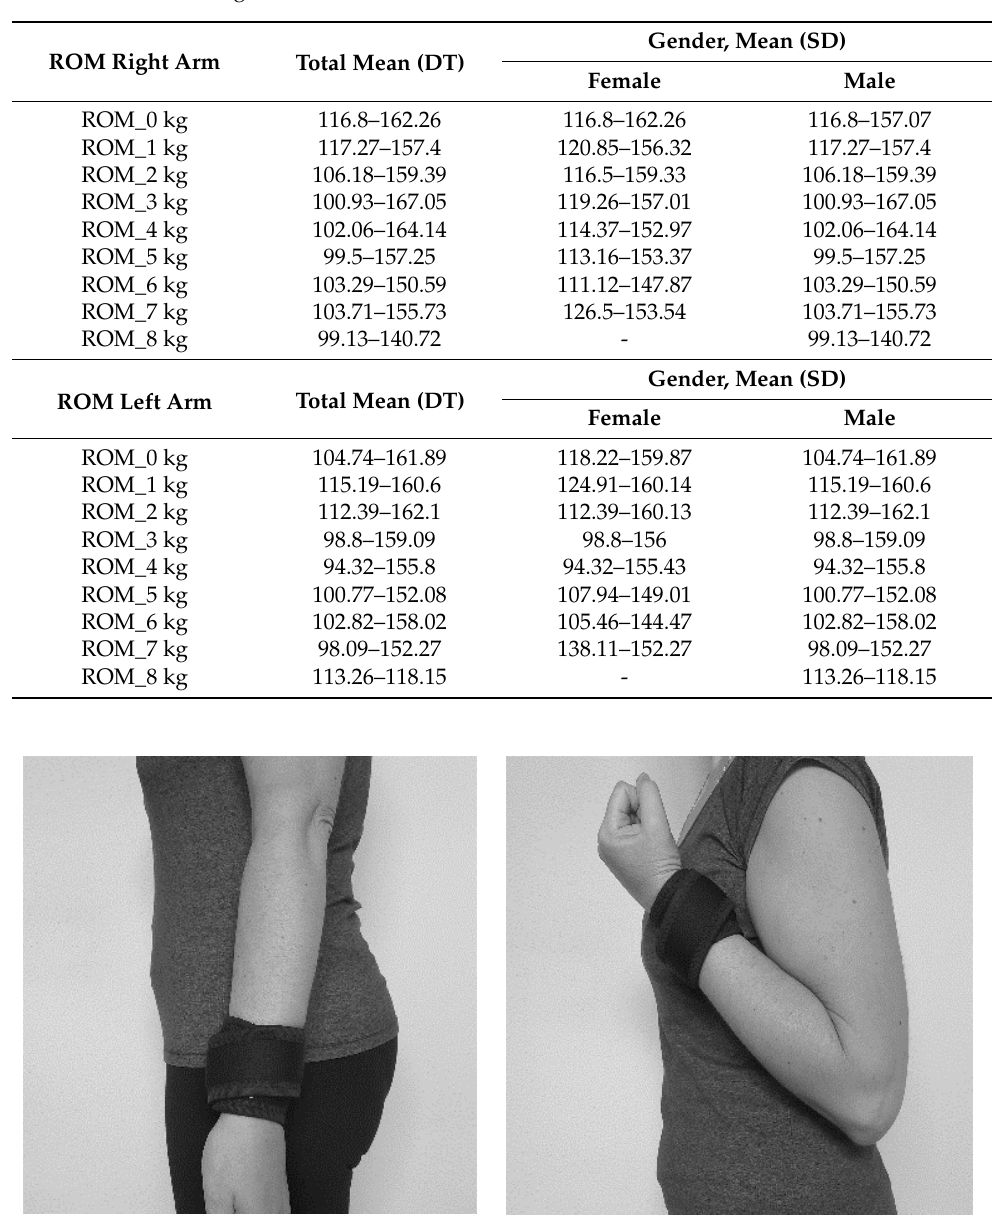
Figure 2. Sensor placement and movement tested.